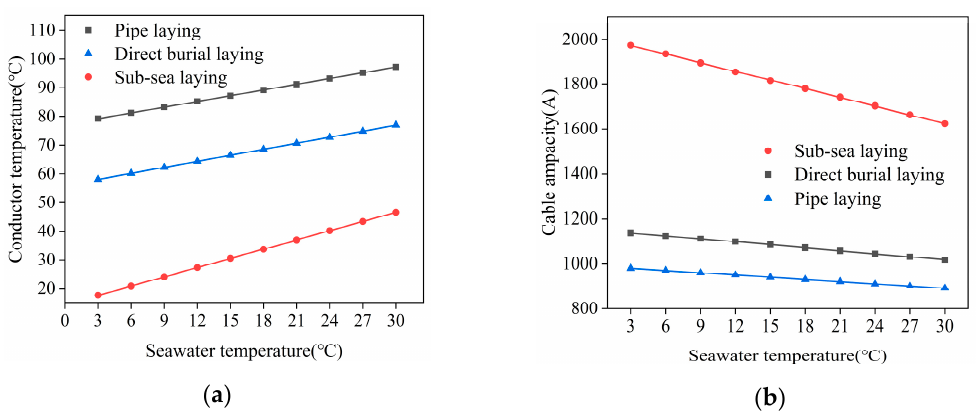
Figure 7. The change curve of the conductor temperature and the submarine cable ampacity. ( a ) The change curve of the conductor temperature for three laying methods. ( b ) The change curve of the submarine cable ampacity for three laying methods.